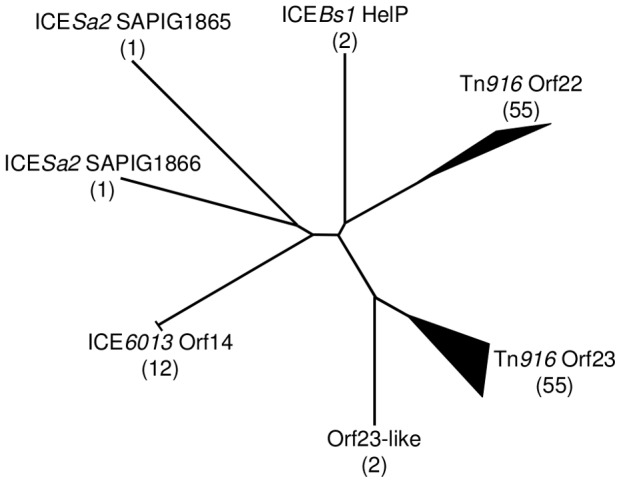
Phylogenic tree of HelP homologues.Using the ICEberg database and search tools (HMMER3 and WU-BLAST2) (http://db-mml.sjtu.edu.cn/ICEberg/), we identified 128 HelP homologues in 72 ICEs. The homologues were analyzed using CLUSTAL X and grouped into clades if they were within a distance of <0.22. The diagram is of an unrooted tree with the number of homologues in each clade shown in parentheses. Branch lengths indicate relative phylogenic distances. The width and length of branch tips indicate the number of homologues and the relative phylogenic distance between homologues in the clade, respectively. Of the seven clades, six are named for a representative ICE and its HelP homologue and one is named “Orf23-like” to reflect its close relationship to the Tn916 Orf23 clade. Twelve homologues in the ICE6013 Orf14 clade have the identical 106 amino acid sequence. The two homologues in the ICEBs1 HelP clade only differ by 5 of 126 amino acids. The two homologues in the Orf23-like clade only differ by 7 of 108 amino acids. Sixteen ICEs encode a single homologue of HelP. These sixteen homologues are from three clades - ICEBs1 HelP (2), ICE6013 Orf14 (12) and Tn916 Orf23 (2). The remaining 56 ICEs encode pairs of HelP homologues. The members of each pair of homologues fall into separate clades as exemplified by Tn916 Orf22 (128 aa) and Tn916 Orf23 (104 aa), and ICESa2 SAPIG1865 (141 aa) and ICESa2 SAPIG1866 (107 aa).